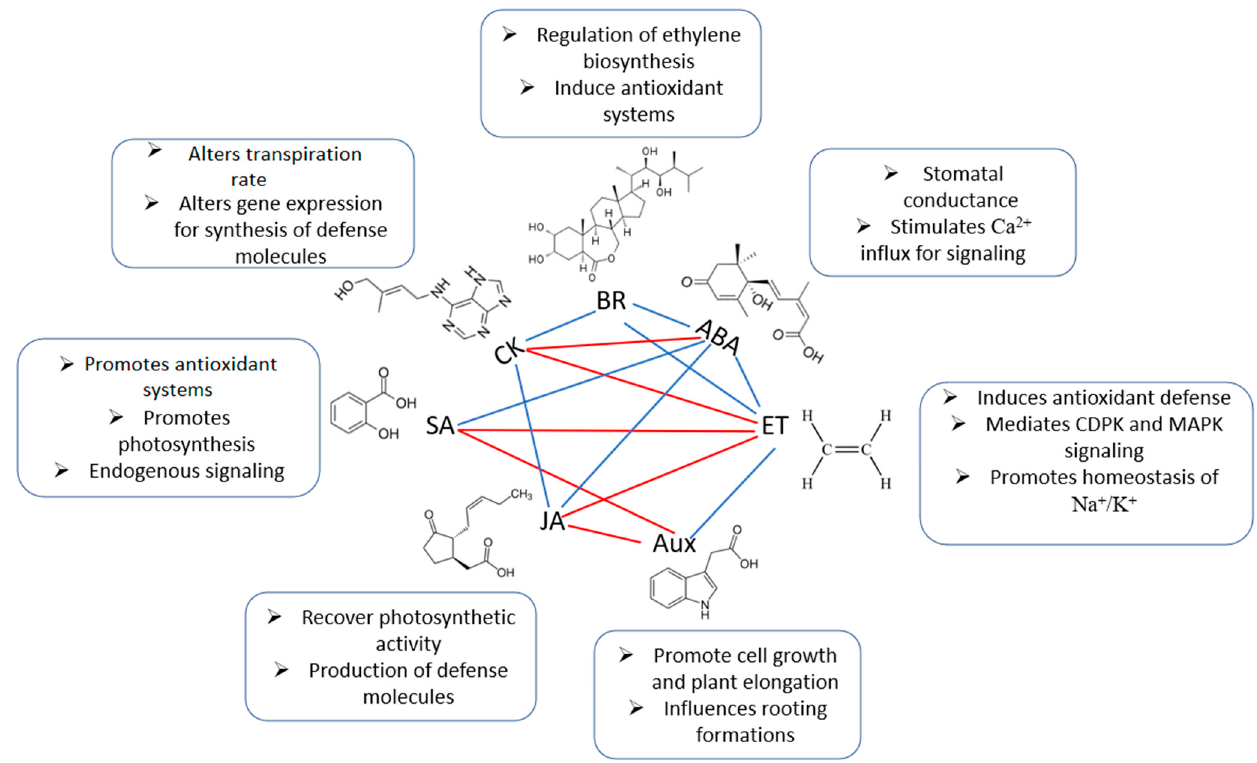
Figure 3. Crosstalk of hormone signalling and their respective roles in response to salinity stress. Phytohormones respond in a complex, coordinated, and interactive manner to alleviate salinity effects and build tolerance. Based on different plant species and the extent of the stress, phytohormones respond with either synergistic (blue lines) or an antagonist (red lines) relationships in their signalling. ABA assumes a predominant position in the complex networking since it interacts with most other plant hormones in stress-responsive signalling pathways. Abbreviations: ABA, abscisic acid; Aux, auxins; BR, brassinosteroids; CK, cytokinins; ET, ethylene; JA, jasmonic acid; SA, salicylic acid.